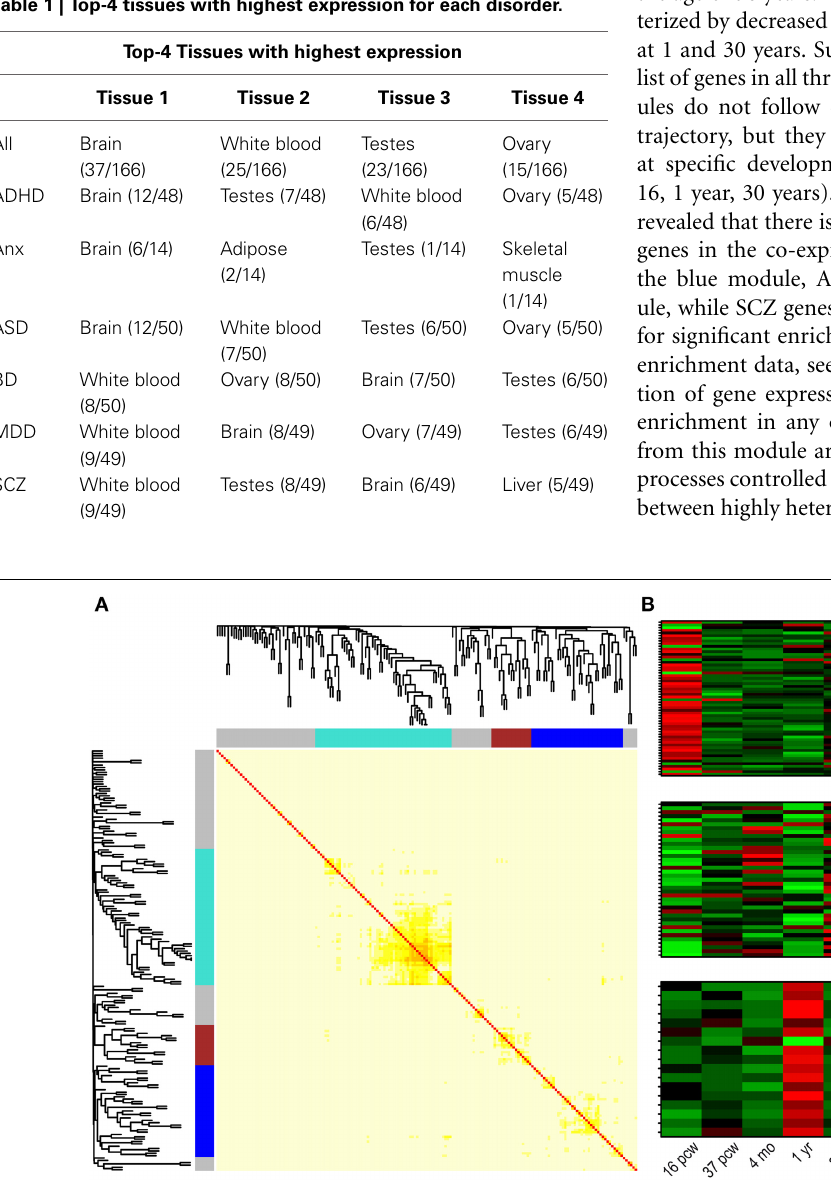
dendrograms. Modules are depicted in colors (turquoise, blue, and brown). (B) Expression heatmap plots for each module. The following abbreviations are used: postconceptional weeks (pcw), months (mo), years